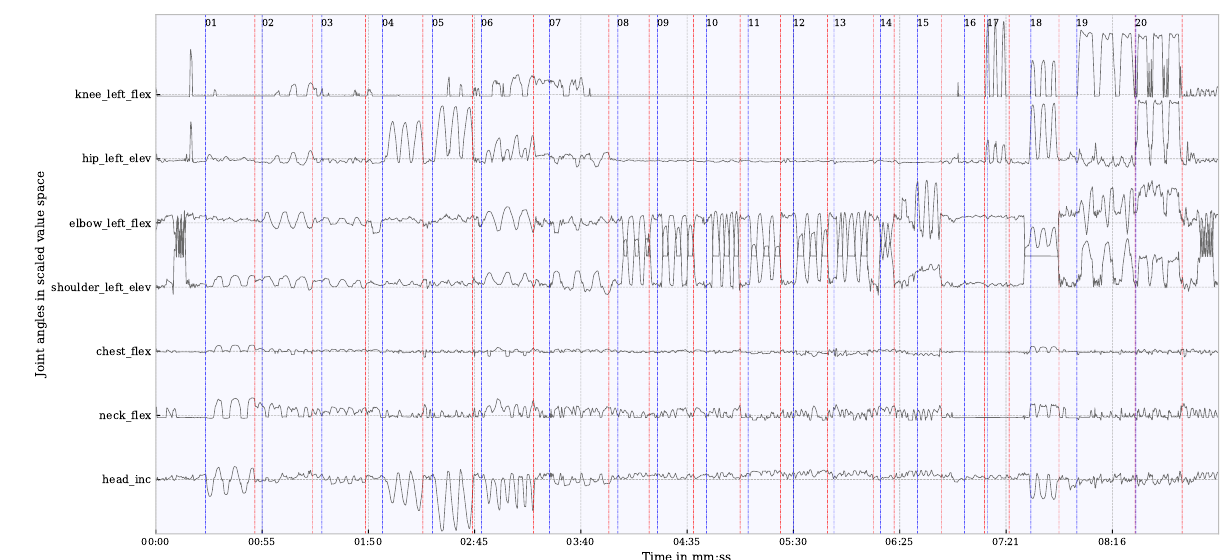
Figure 6. Time series of some exemplary selected joint angles. Time segments of the examined movements (01–20) are marked as vertical lines. Start of a movement in blue; end of the movement in